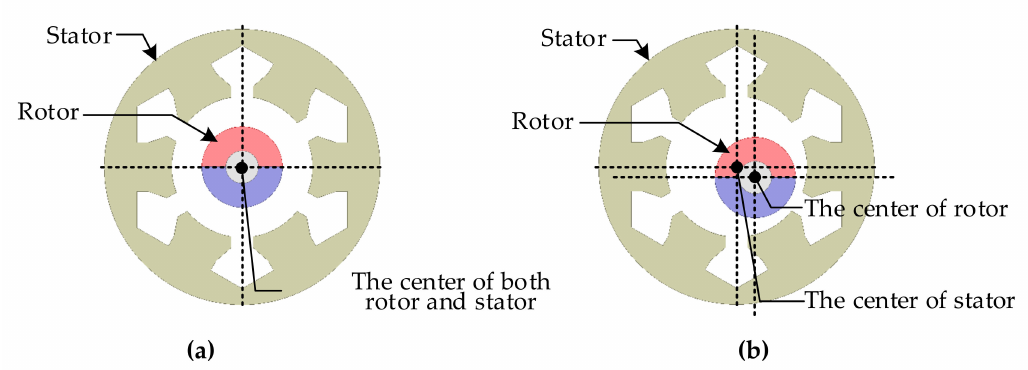
Figure 4. Illustrations of rotor eccentricity: ( a ) no eccentricity and ( b ) the eccentricity from the stator center.